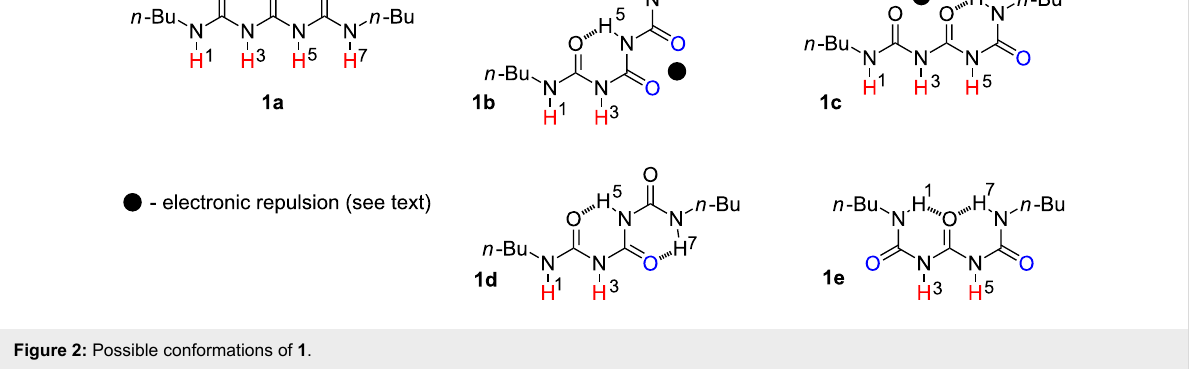
Figure 2: Possible conformations of 1 .